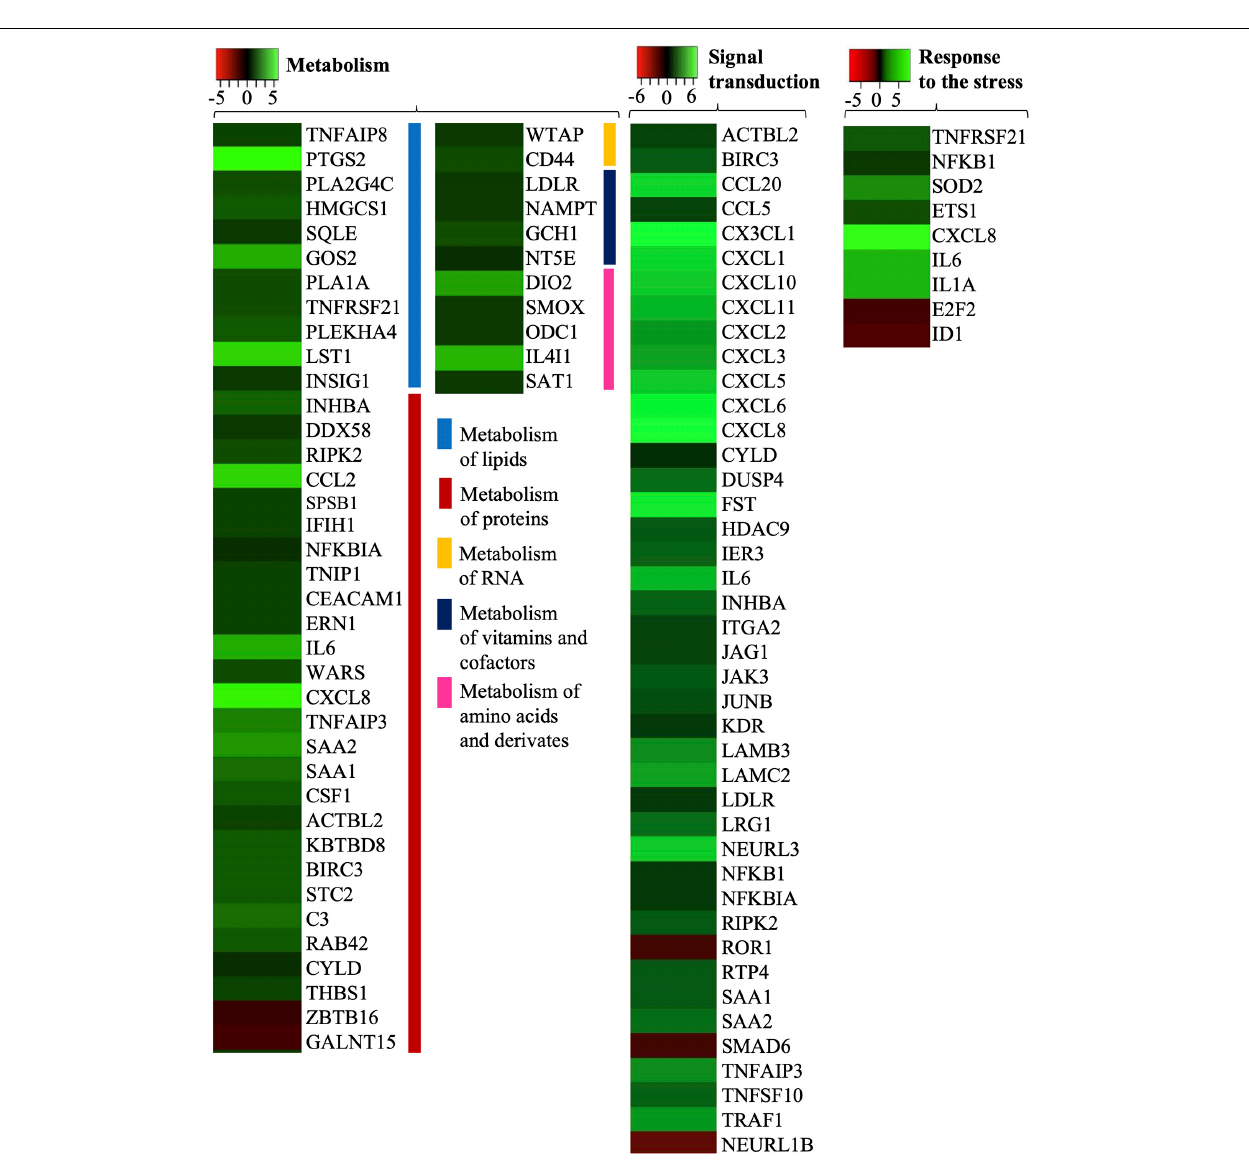
FIGURE 3 | Gene ontology biological processes (response to the stress, metabolism, and signal transduction) activated by B. bavariensis in hBMECs. Green shaded genes—upregulated, red shaded genes—downregulated. The intensity of the color indicates the degree of expression level. The range of the fold change (logFC) is presented in the